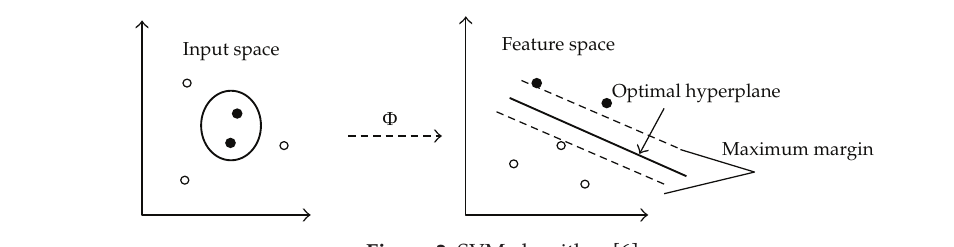
Figure 2: SVM algorithm (cid:6) 6 (cid:7) . Table 1: Characteristic